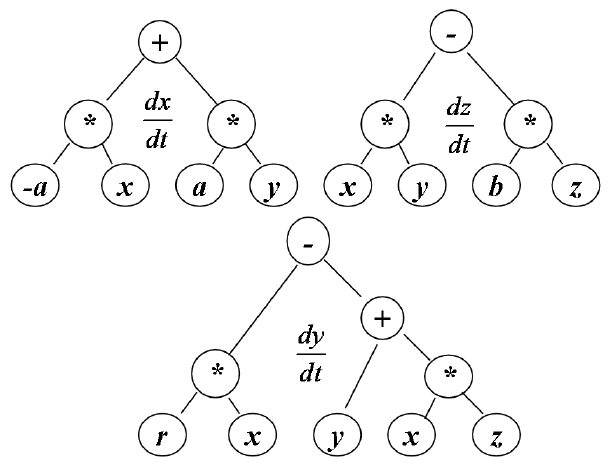
Fig. 1. Hierarchical structure diagram of binary tree of the Lorenz